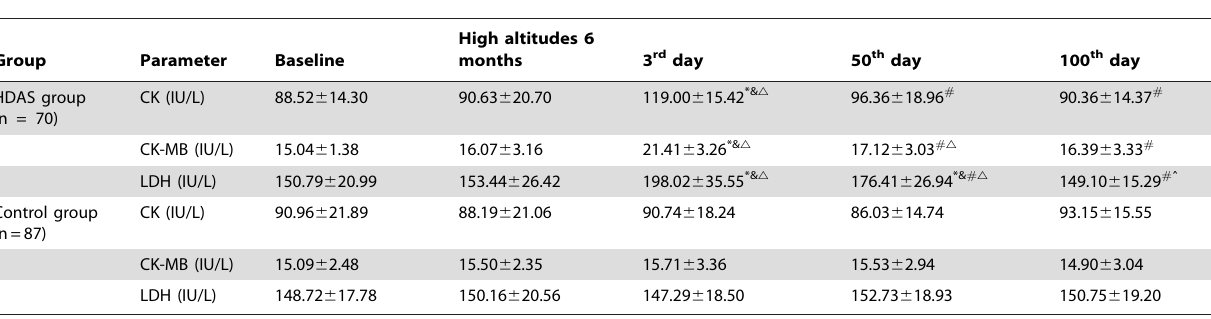
Table 9. Serum CK, CK-MB, and LDH of subjects after returning to Kunming.